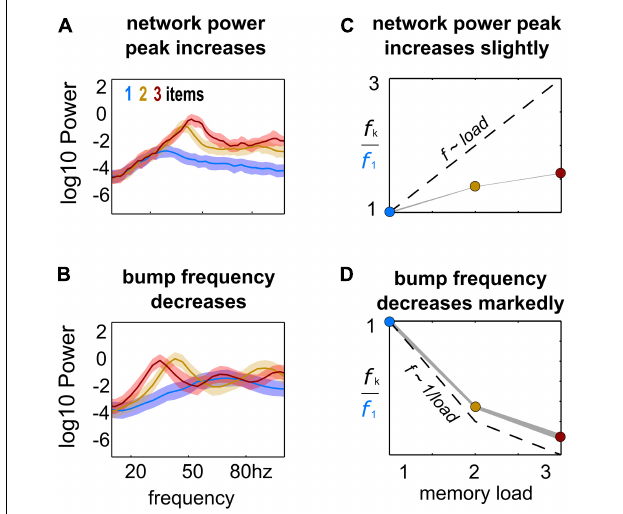
FIGURE 2 | Load-modulation of network and bump oscillatory dynamics. Power spectrum of LFPs computed from simulations with increasing load (1–3), using the activity of the whole network (A) or of each bump’s activity (B) . (C,D) Peak-frequency f k computed from simulations with increasing load k , normalized to frequency f 1 from simulations with a single bump and computed from LFPs of the whole network activity (C) and from LFPs of each individual bump’s activity (D)